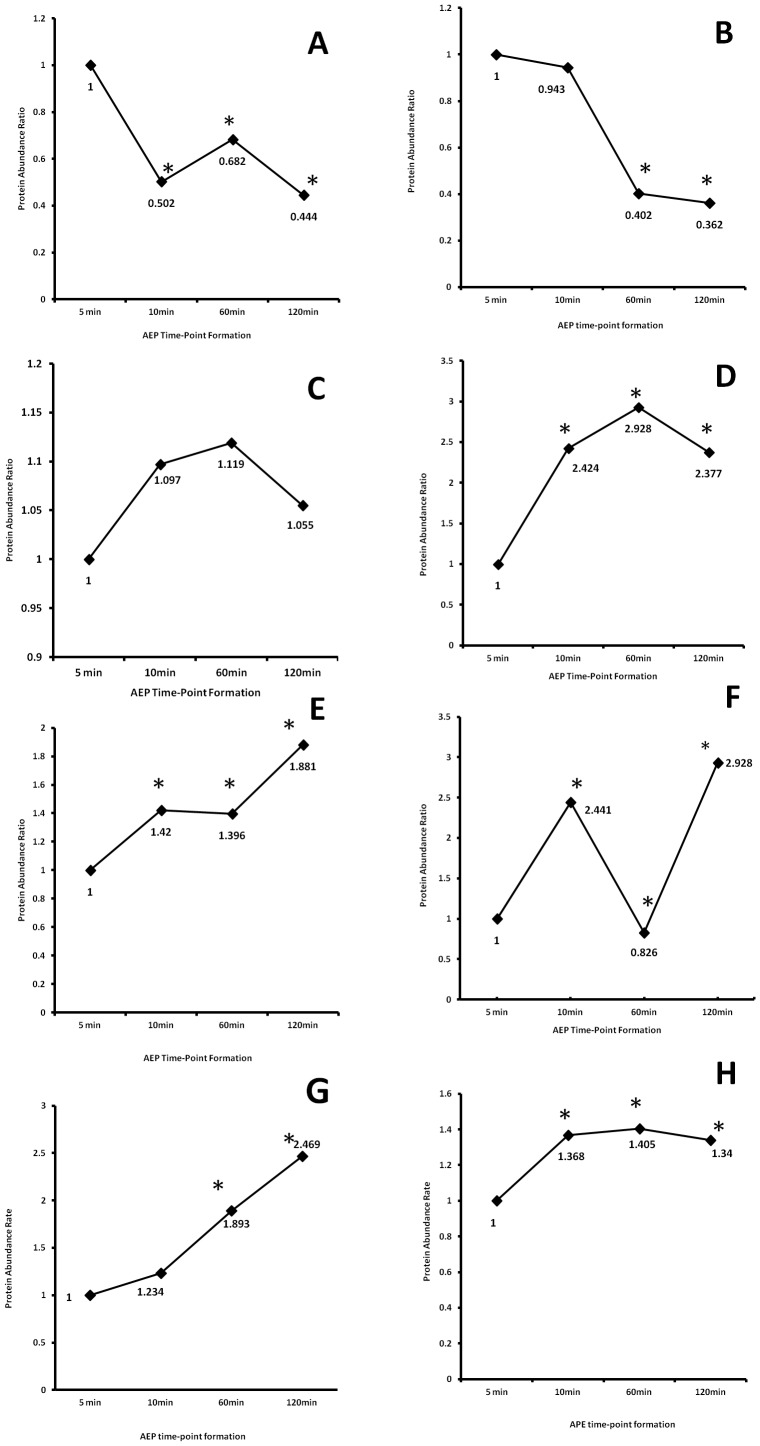
Time course of changes in the abundance of specific AEP proteins.(A) histatin 1, (B) histatin 3, (C) statherin, (D) acidic PRP1, (E) amylase, (F) MUC5B, (G) lysozyme, (H) lactoperoxidase. Note: * denotes statistical difference when compared with 5-min AEP time-point. p>0.05.